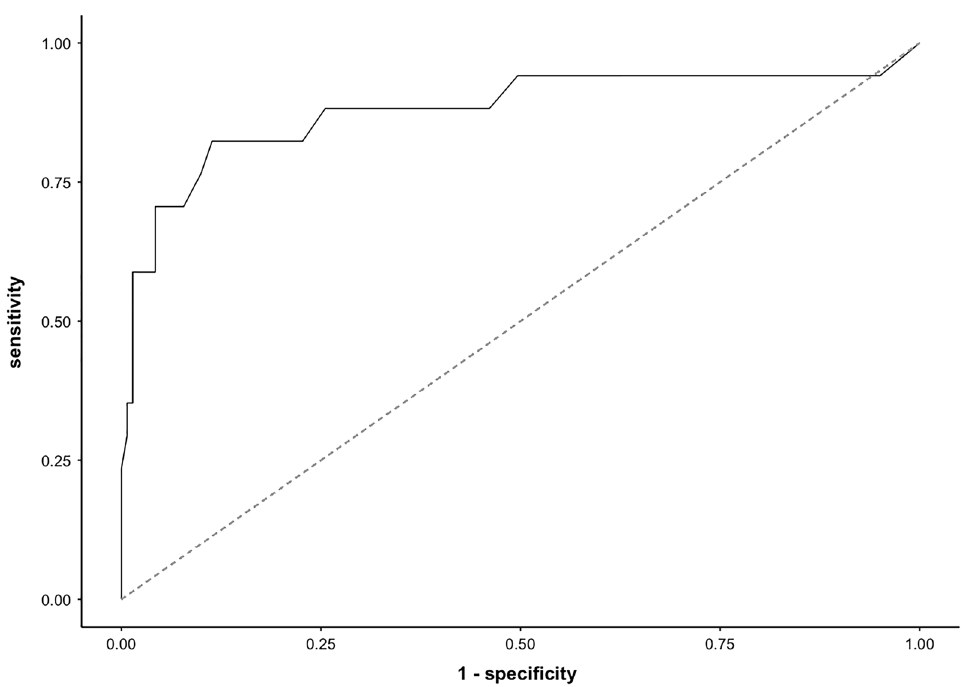
Figure 4. Receiver operating characteristic curve for random forest (RF) model in BSI prediction (AUC